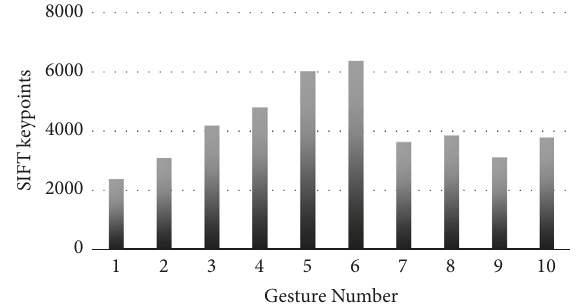
Figure 5: Number of SIFT keypoints at 𝜎 = 1.8